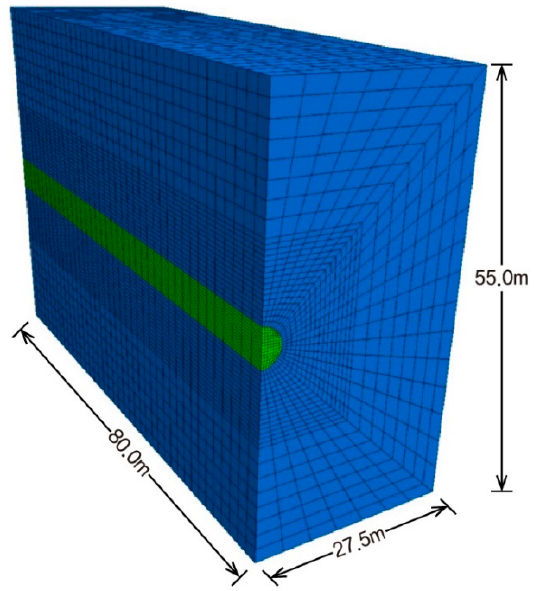
Figure 5. Numerical model for calculating the LDP.